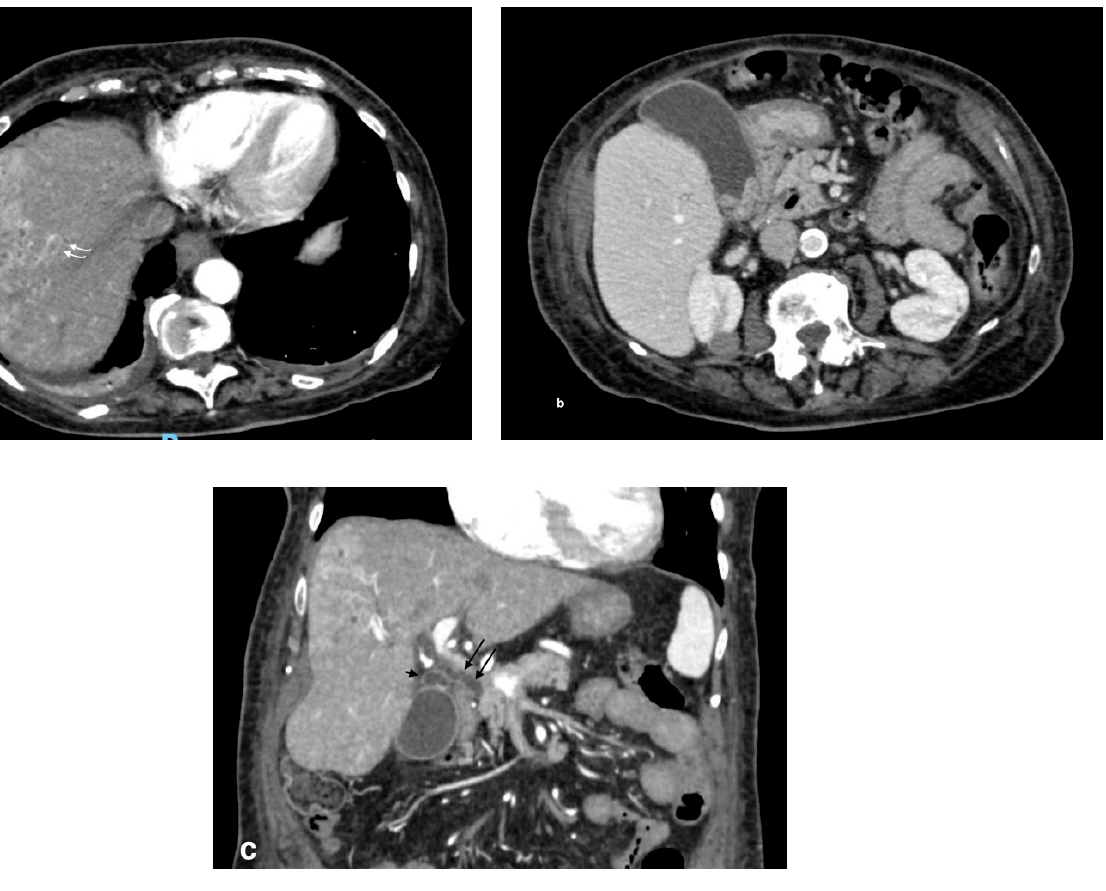
Figure 7. Cholangitis with microabscesses: ( a ) axial image shows patchy biliary intrahepatic duct dilation (curved arrows) and small hypodense collections due to microabscesses (white arrows); ( b ) overdistended gallbladder with infundibular stones and thickening of the gallbladder due to calculous cholecystitis; ( c ) coronal scan shows a dilated common bile duct (arrow) and cystic duct (arrowhead) with wall hyperdensity due to inflammation.